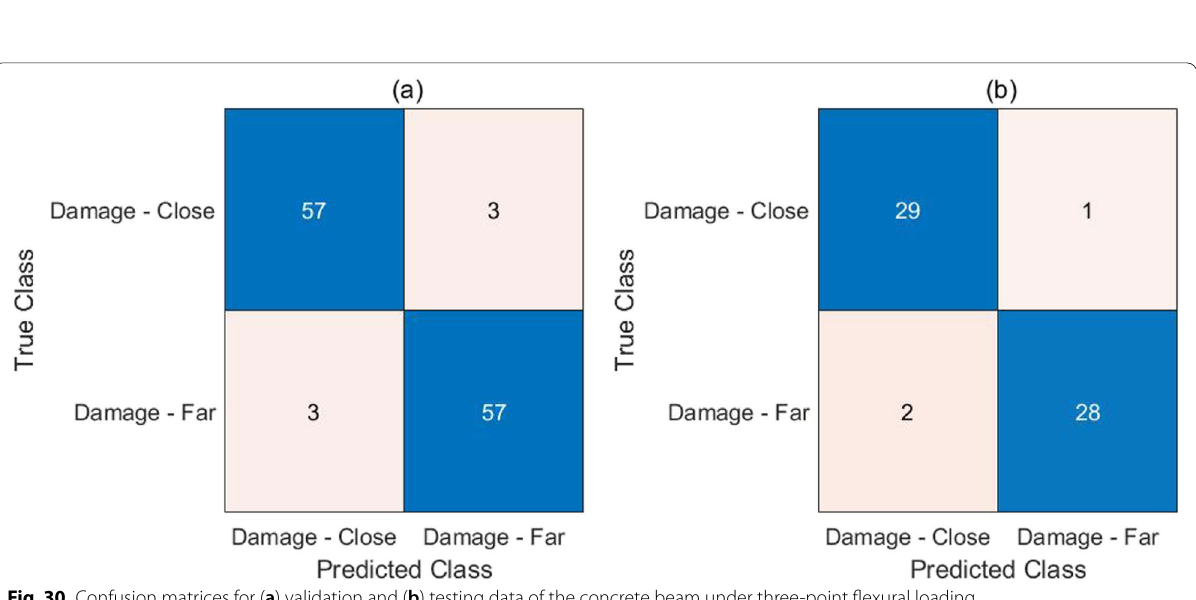
(second column). It can be seen that the amplitude of the AE waveform obtained from A1 and A2 are the same. Thus, the amplitude of the time-history of raw AE data might provide inaccurate information for the crack loca- tion, which motivates to apply the proposed method to automate the process of identifying the potential loca- tion of the crack in the concrete beam. In order to predict the approximate location of the crack, the CWT spec- trograms of IMFs extracted from A 1 and A 2 (defined as